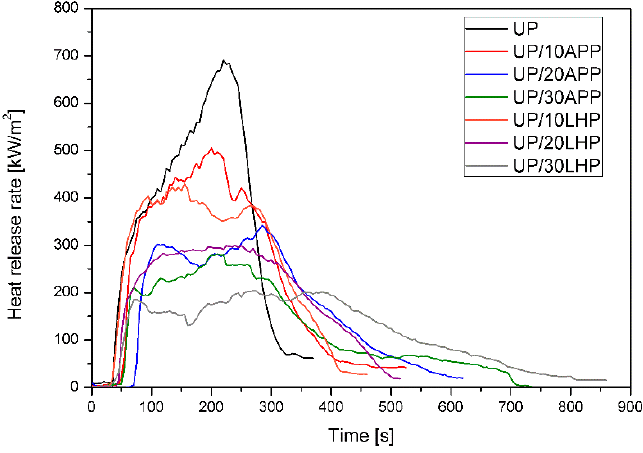
Figure 7. Representative curves of the heat release rate of the UP and UP/IFRs.